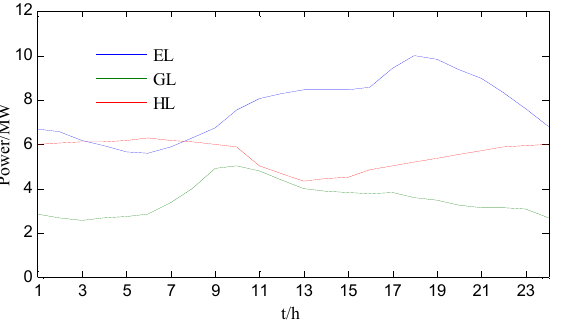
Figure 3. The electricity/gas/heat consumption in industrial park during the day.